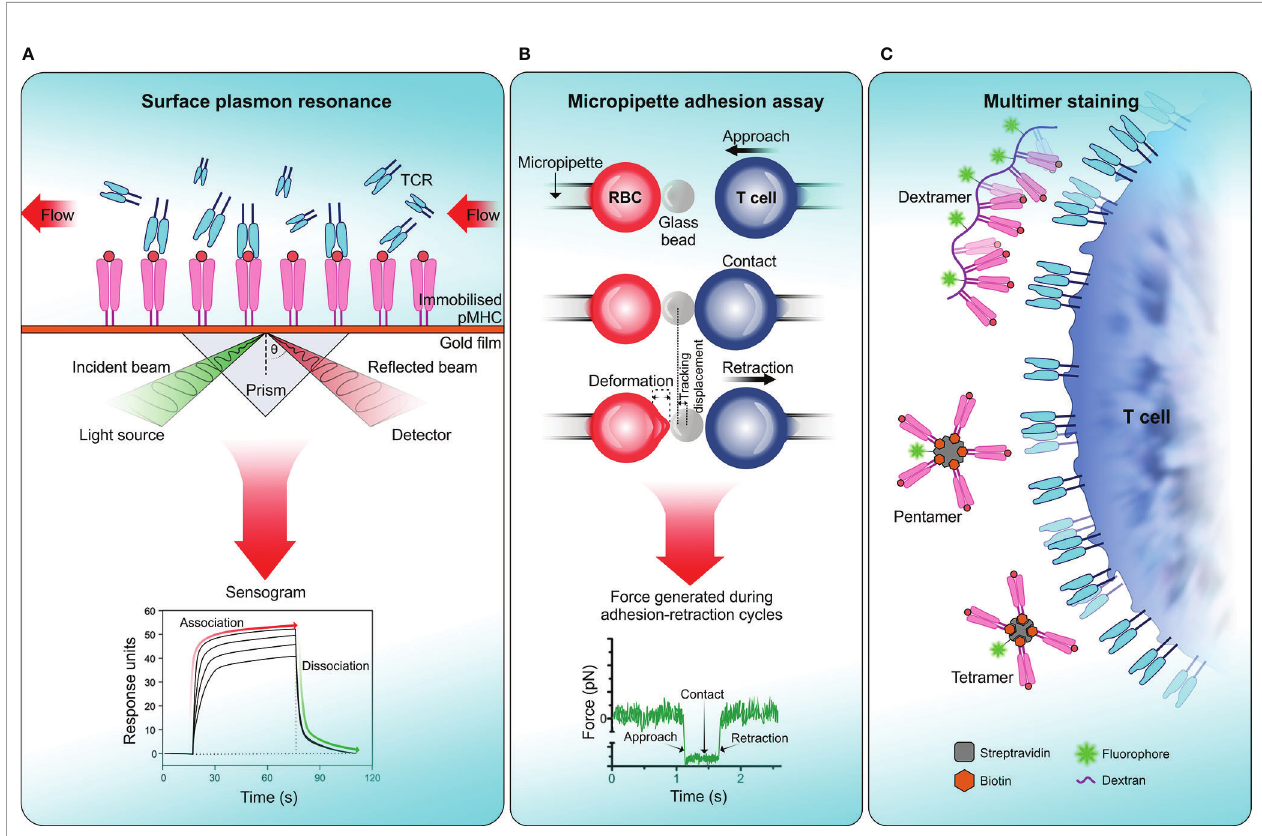
FIGURE 3 | Measuring TCR af fi nity. (A) Surface plasmon resonance (SPR). SPR measures the equilibrium dissociation constant ( K D ) of TCR-pMHC interactions in which pMHC is immobilized on a sensor surface and TCR molecules are injected in a continuous fl ow. Binding of TCR to pMHC results in a change of mass on the sensor surface and is recorded in a sensogram which is then used to calculate K D . (B) Micropipette adhesion assay. This technique uses two probes, one that is stationary which contains a red blood cell (RBC) attached to a functionalized glass bead to act as the adhesion force transducer and a mobile force probe bearing a T cell coupled to a piezotranslator. During adhesion-retraction cycles carried out by the mobile probe, the deformation of the RBC, displacement of the glass bead and the force generated in each cycle is recorded. (C) Multimer staining. This technique enhances the binding avidity of TCR-pMHC by increasing the valency of the interaction, results in more stable multimeric TCR-pMHC complexes for ef fi cient labelling and detection. To date numerous forms of pMHC multimers have been reported which includes tetramers, pentamers, octamers, and dextramers